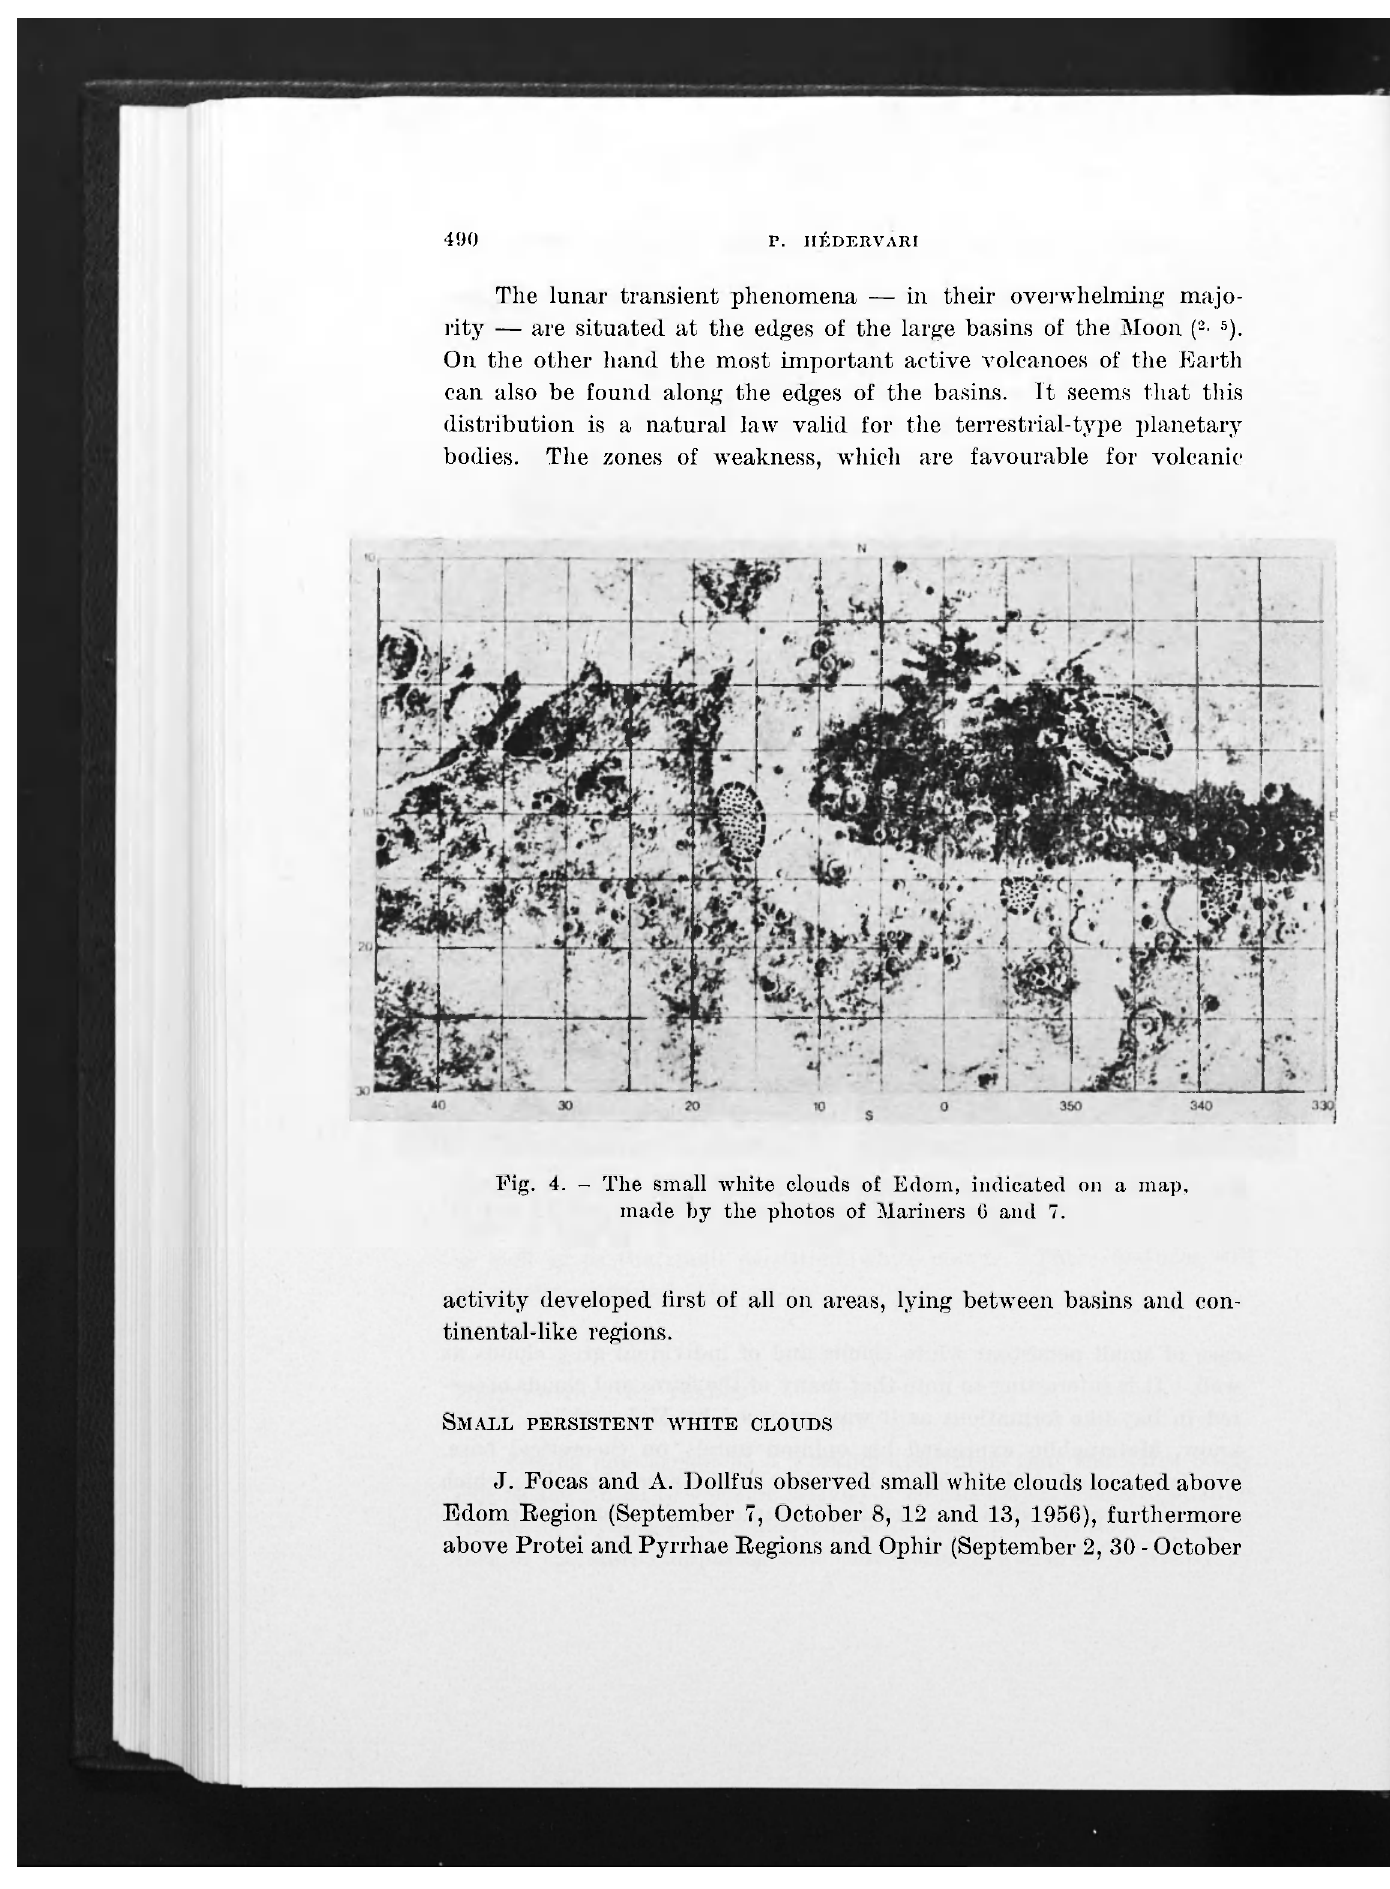
Fig. 4. - The small white clouds of Edom, indicated on a map, made by the photos of Mariners G and